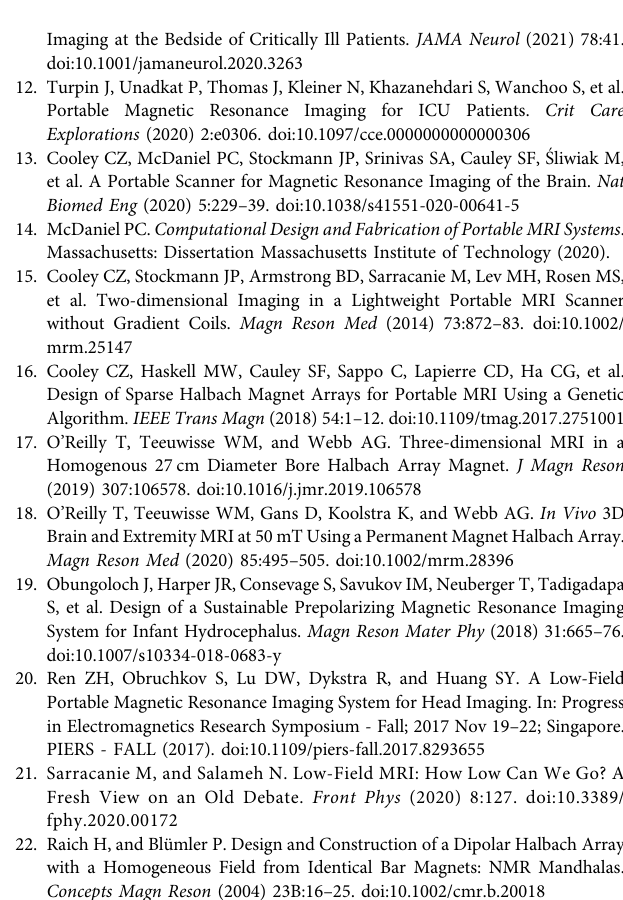
Supplement Figure 1 | Photographs of the constructed gradient coils where 1.5 mm diameter enameled copper wire is pressed into the grooves of a 3D printed cylindrical mold, shown for the old (A) and new method (B) . Supplement Figure 2 | Photograph of point source phantom together with a single layer. Supplement Figure 3 | A schematic of one of the channels of the battery-operated gradient ampli fi er. Supplement Figure 4 | Photograph of the Gradient ampli fi er. Supplement Figure 5 | Photograph of the quality assurance phantom, inside the solenoidal